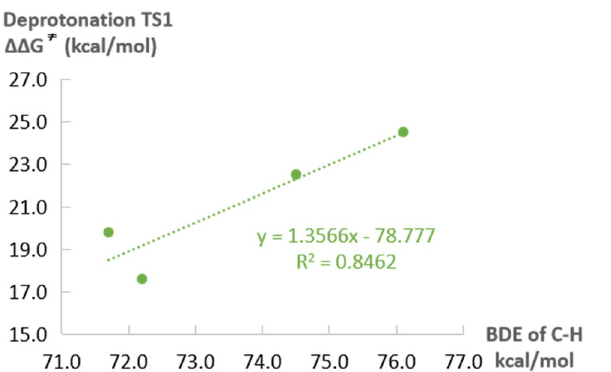
Figure 4. The relationship between deprotonation the energy barriers and the corresponding C–H bond dissociation energy (BDE) for different